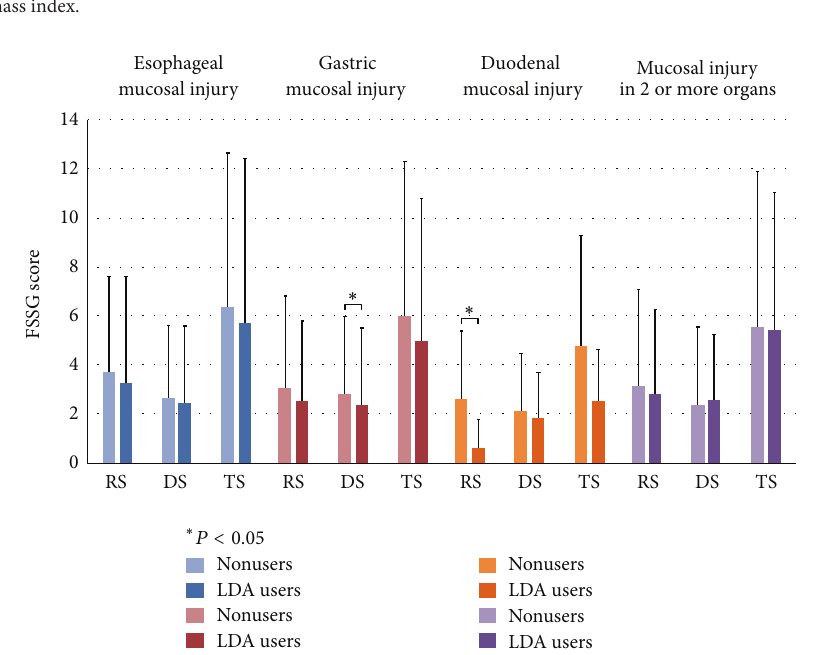
Figure 4: FSSG score of subjects with mucosal injury among LDA users and nonusers. Among LDA users and nonusers, respectively, the scores forTS, RS, and DS were 5.8 ± 6.6 and 6.4 ± 6.3 ( 𝑃 = 0.29 ), 3.3 ± 4.3 and 3.7 ± 3.9 ( 𝑃 = 0.17 ), and 2.5 ± 3.1 and 2.7 ± 2.9 ( 𝑃 = 0.46 ) for EI; 5.0 ± 5.8 and 6.0 ± 6.3 ( 𝑃 = 0.05 ), 2.6 ± 3.2 and 3.1 ± 3.7 ( 𝑃 = 0.09 ), and 2.4 ± 3.1 and 2.9 ± 3.1 ( 𝑃 = 0.04 ) for GI; 2.6 ± 2.1 and 4.8 ± 4.5 ( 𝑃 = 0.16 ), 0.7 ± 1.1 and 2.6 ± 2.8 ( 𝑃 = 0.01 ), and 1.9 ± 1.8 and 2.2 ± 2.3 ( 𝑃 = 0.77 ) for DI; and 5.5 ± 6.3 and 5.6 ± 5.5 ( 𝑃 = 0.60 ), 2.9 ± 3.9 and 3.2 ± 3.4 ( 𝑃 = 0.22 ), and 2.6 ± 3.1 and 2.4 ± 2.6 ( 𝑃 = 0.97 ) for mucosal injury in 2 or more organs. RS = reflux score, DS = dysmotility score, and TS = total